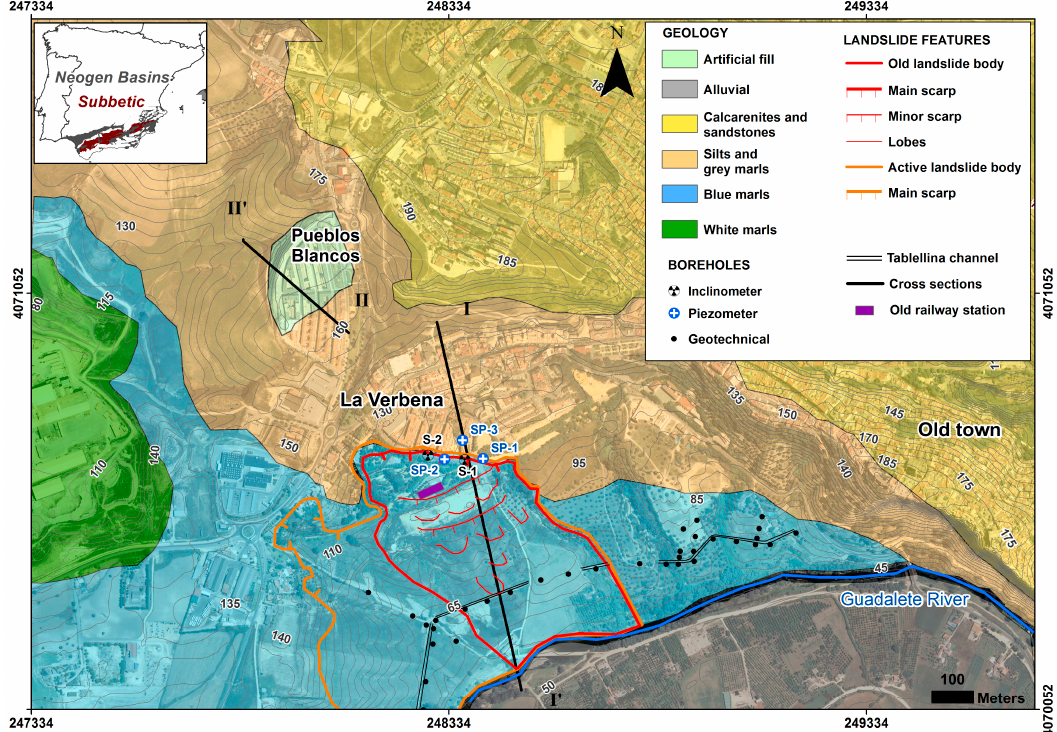
Figure 2. Local geology of the studied area. Old and active landslide features are identified. The Tablellina water channel trace is discontinuous because it is partially buried.